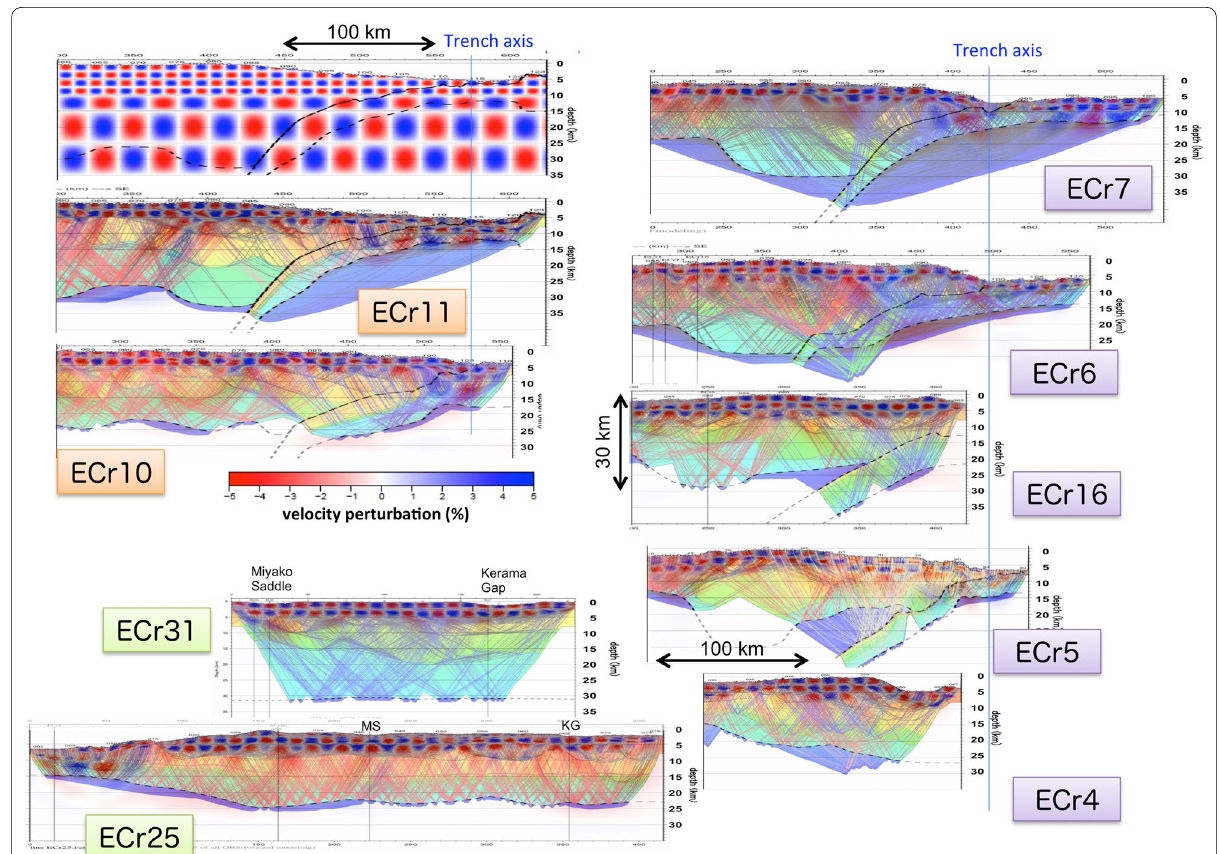
Fig. 5 Resolution of each P -wave velocity model. The top left shows the checkerboard test initial pattern of the tomographic inversion for ECr11. Ray coverage is also plotted from the forward modeling, including reflection